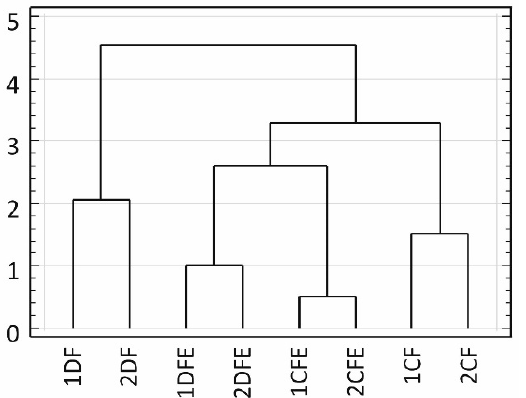
Figure 5. Clustering of ecotone complex zones by the composition and percentage cover of vascular plant species in the ground layer. Ecotone zones are along the abscissa, and distance is along the ordinate. Note: CF—coniferous forest, CFE—coniferous forest edge, DFE—deciduous forest edge, DF—deciduous forest.